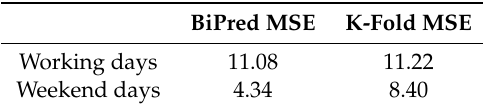
Table 5. MSE comparison between polynomials computed by the BiPred and K-fold